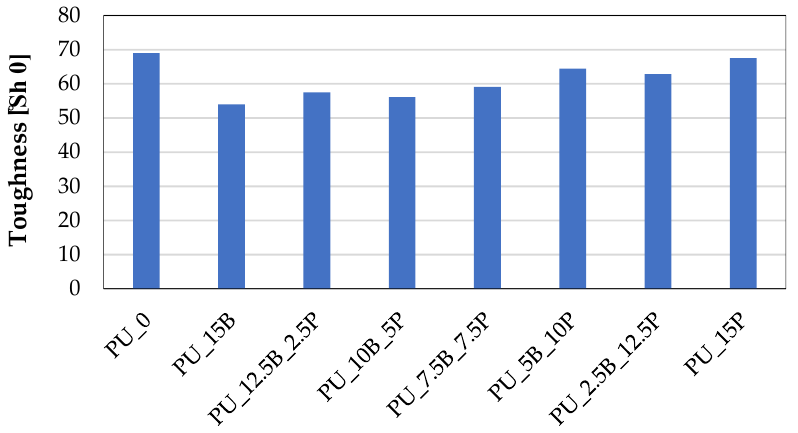
Figure 7. Toughness of rigid PU foams containing buckwheat hulls and perlite.